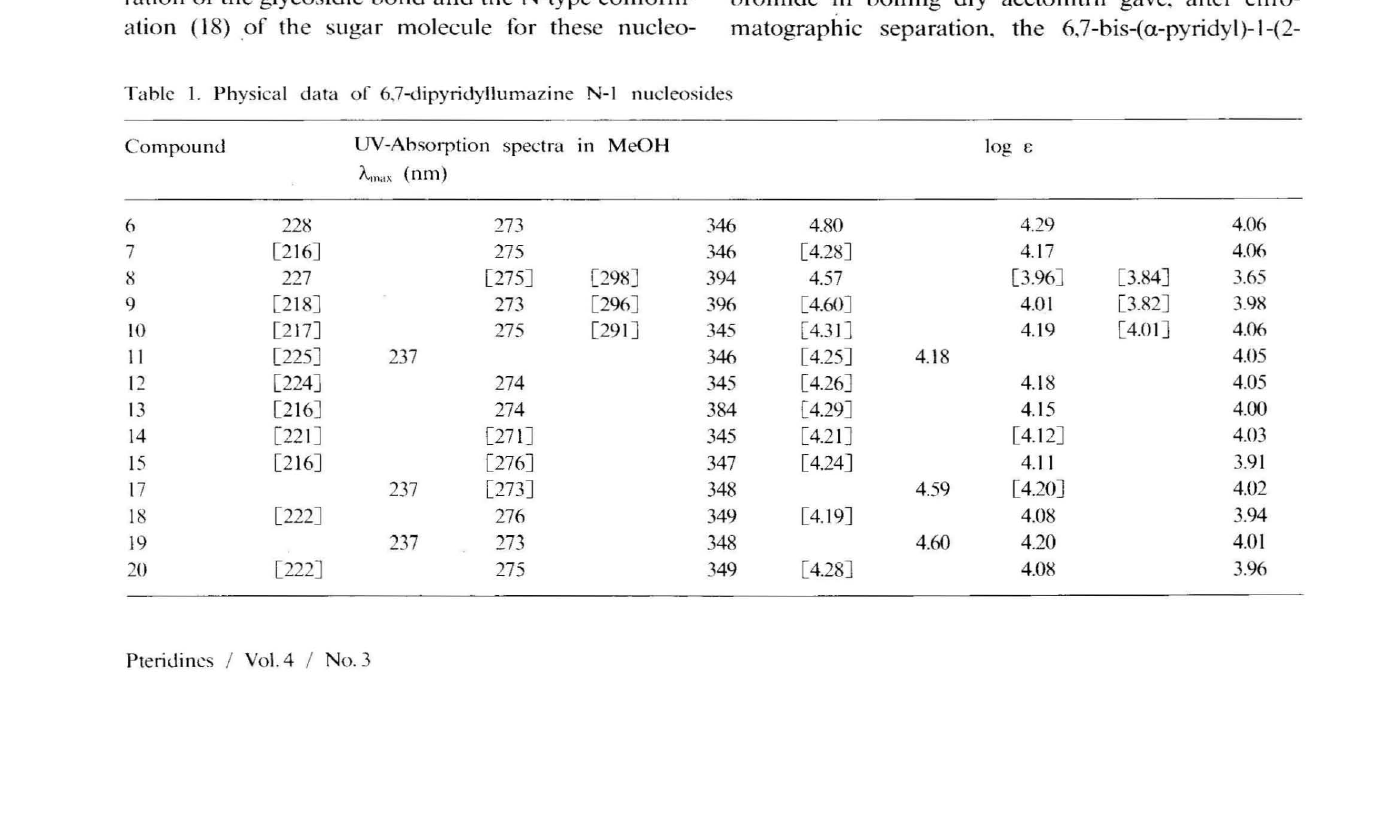
Table L Physical data of 6.7-dipyridyllumazine N-I nucleosides